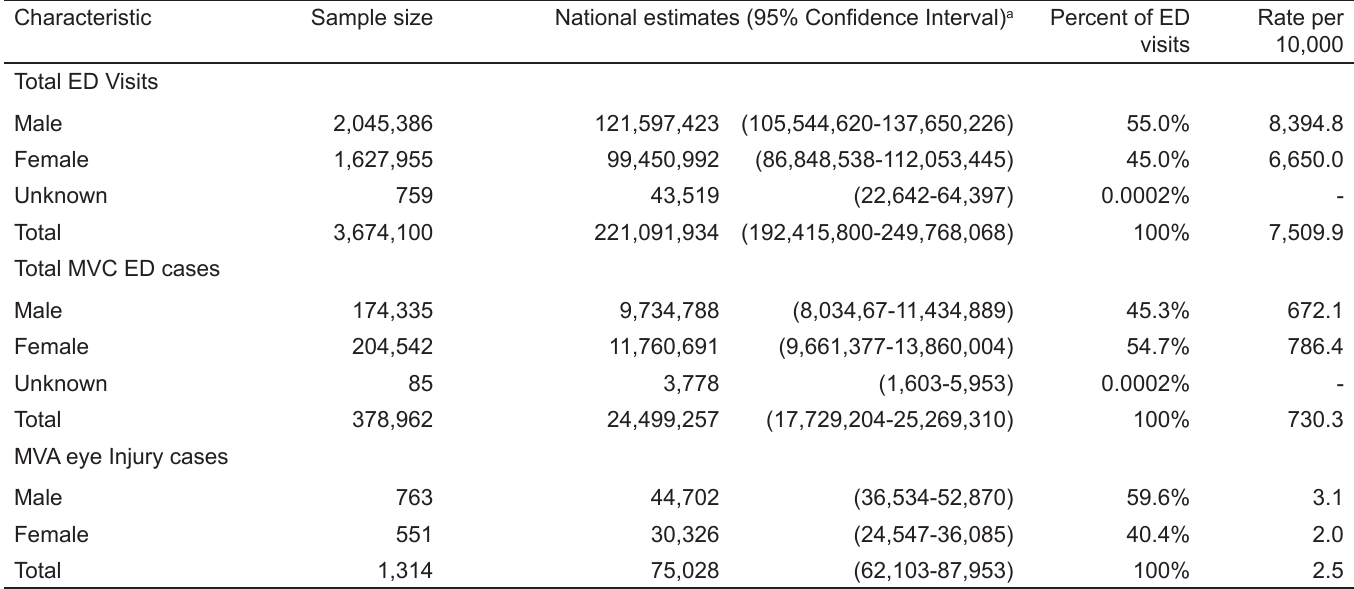
Table 2. Demographics of United States emergency department visits from 2001-2008, including motor vehicle crash and eye injury